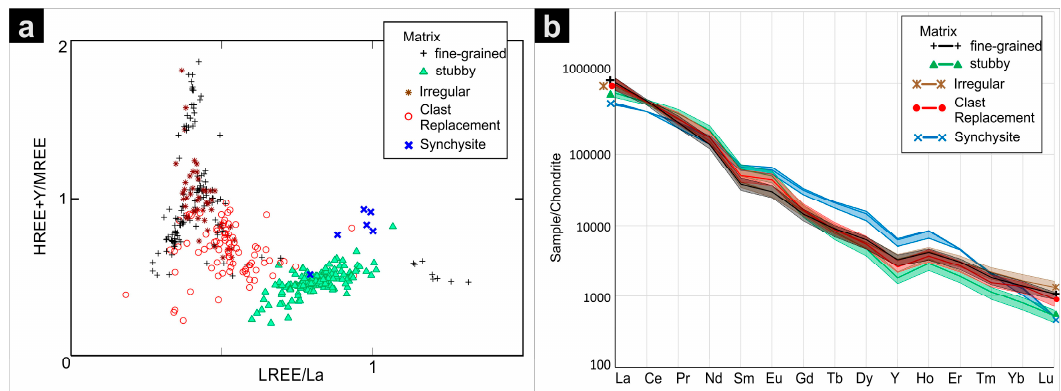
Figure 9. Compositional variation (LA-ICP-MS data) for REE in bastnäsite and synchysite; ( a ) (HREE + Y)/MREE vs. LREE/La, where HREE = (Tm + Yb + Lu + Y), MREE = (Gd + Tb + Dy + Ho + Er), and LREE = (Pr + Nd + Sm). LREE/La separates out those grains relatively enriched in La (irregular, fine-grained cement and clast replacement bastnäsite) from those with a more diverse LREE signature (stubby matrix bastnäsite and synchysite). The plot also exposes the relative enrichment in (HREE + Y) in irregular and fine-grained cement bastnäsite (those with highest HREY/MREY are fine-grained cements from sample RX6724) and relative MREE enrichment in stubby matrix bastnäsite and synchysite. Fine-grained cement bastnäsite with high (Pr + Nd + Sm) plots at the extreme right (sample RX6723); ( b ) Chondrite-normalized REY fractionation trends for the different groups of REE-fluorocarbonates (LA-ICP-MS data). Chondrite values after [36]. See also text for additional explanation.